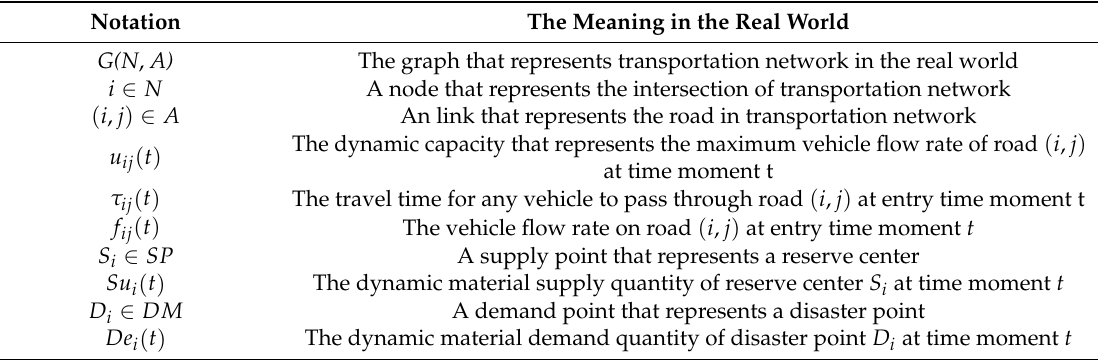
Table 1. The notations employed in the mathematical model.